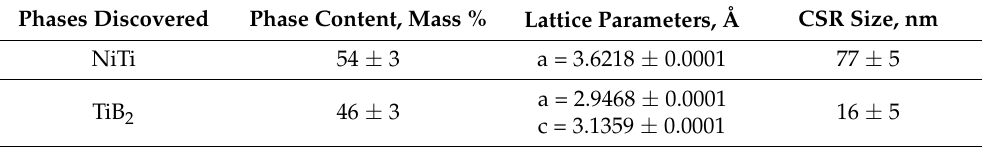
Table 1. Results of the X-ray diffraction analysis of NiTi-TiB 2 composites fabricated by high-temperature vacuum